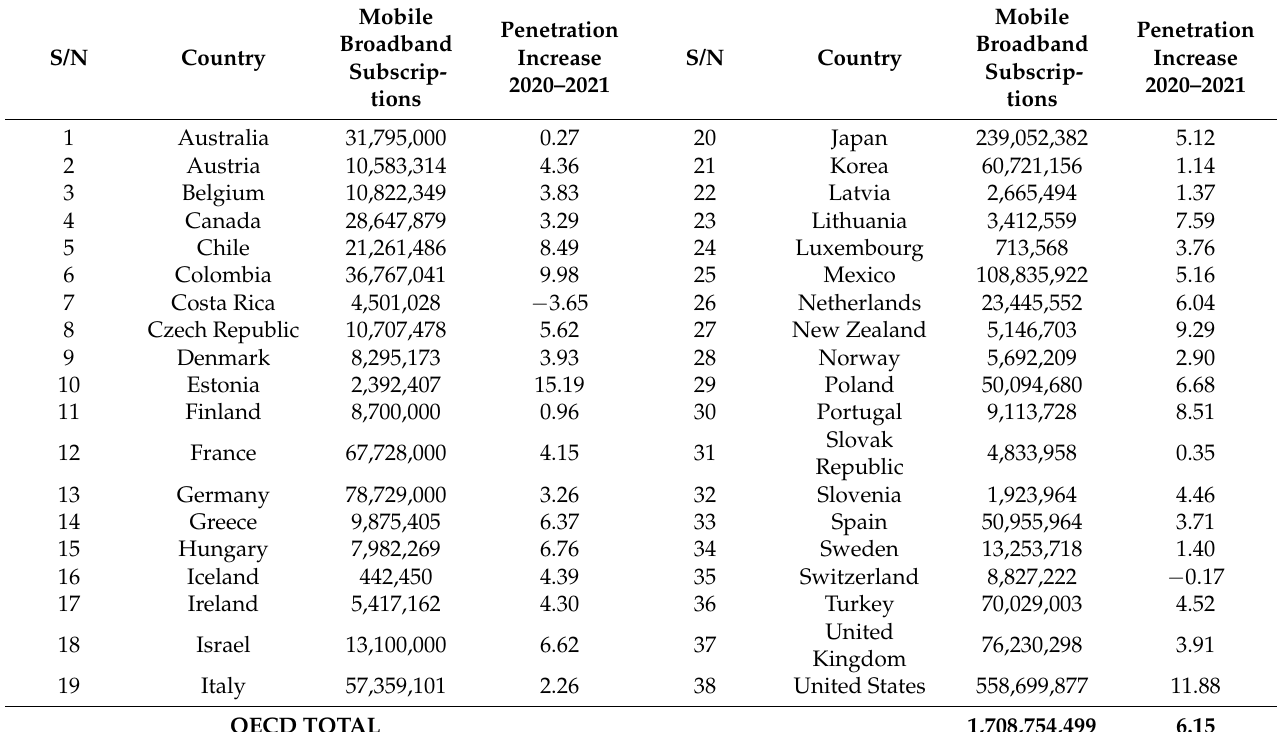
Table 4. Growth in active mobile broadband (3G and above) subscription in millions by